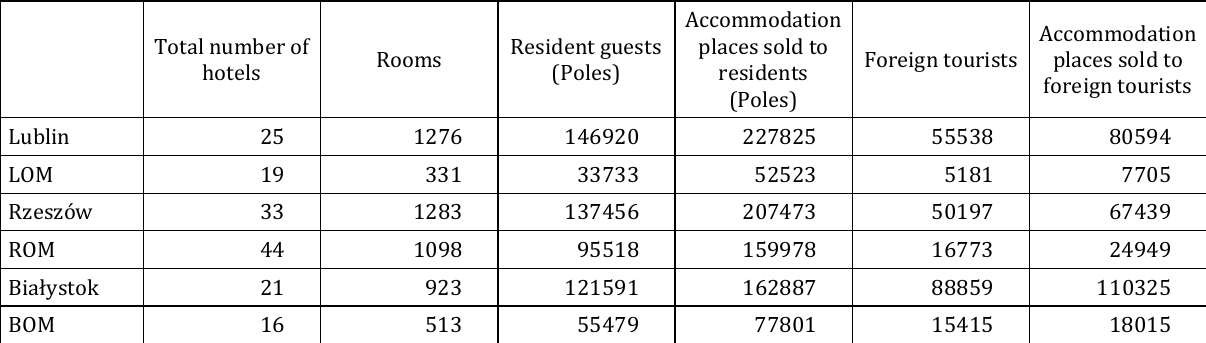
Table 3. Accommodation base in the Białystok, Lublin and Rzeszów Metropolitan Areas (2014) (author’s own elaboration based on data of the Local Data Bank of the Central Statistical Office) Accommodation Total number of Resident guests places sold to Rooms hotels (Poles) residents (Poles)